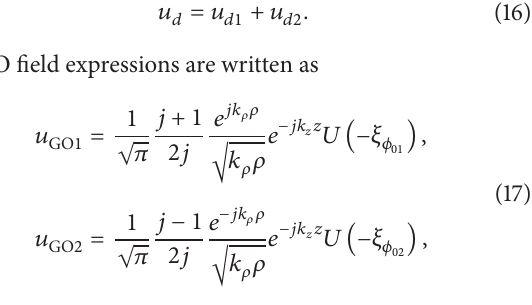
[𝑟 2 +𝑎 2 −2𝑟𝑎 sin 𝜃] 1/2 . The related angles are given in Figure